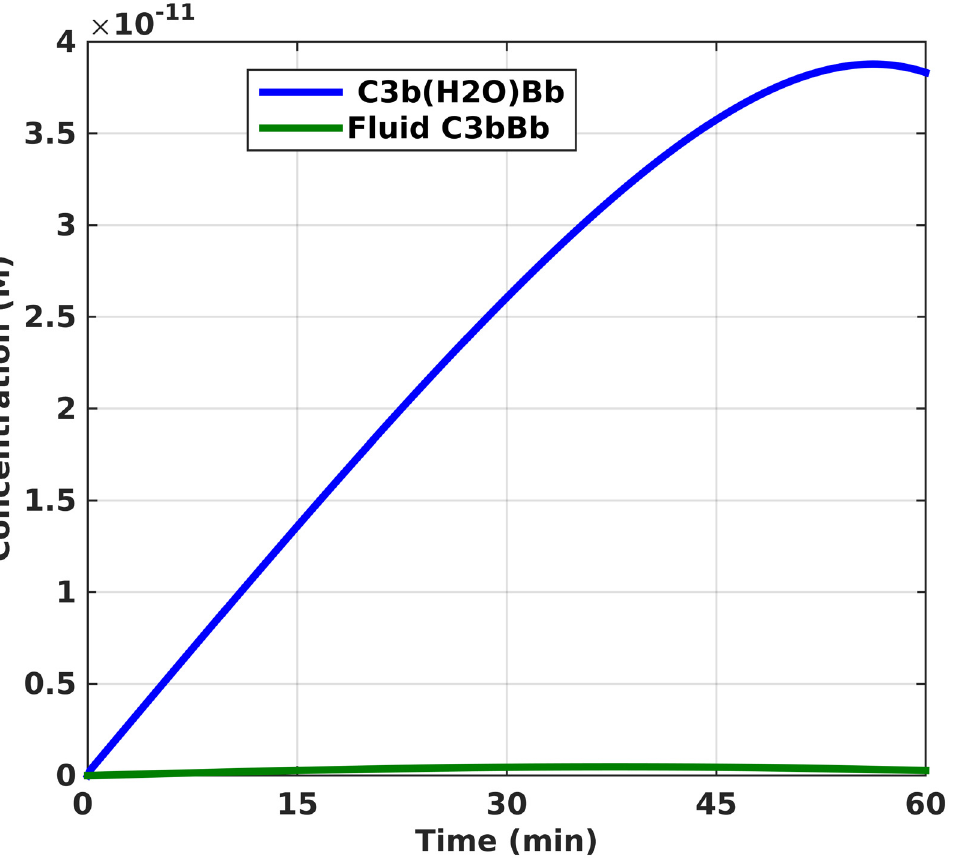
Fig 3. Concentration of assembled fluid phase convertases, C3(H 2 O)Bb and C3bBb, of the alternative pathway. The time profiles show that the concentration of C3(H 2 O)Bb increases significantly within 60 minutes compared to the concentration of